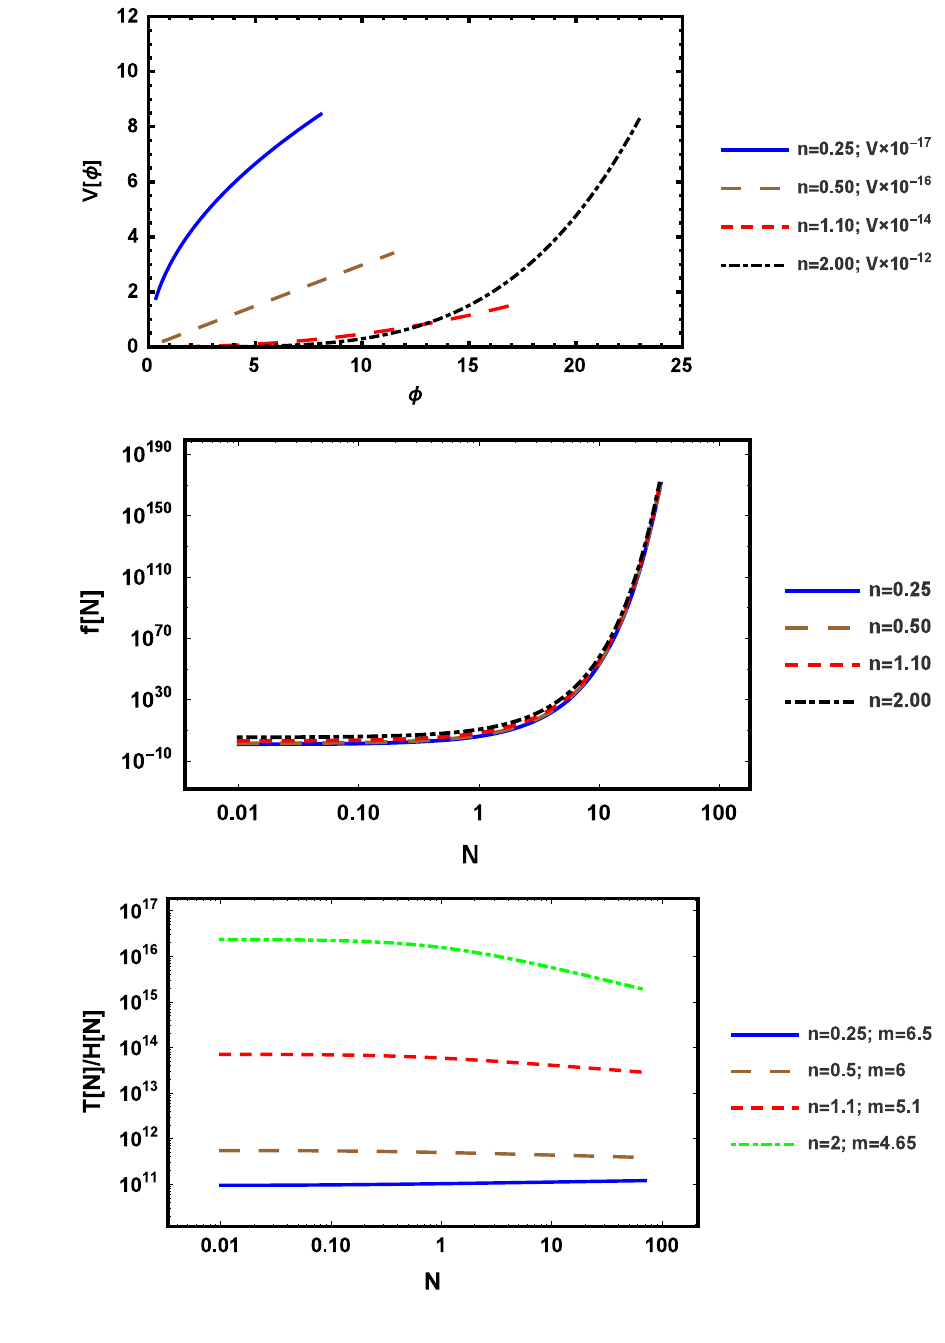
Fig. 3 The behavior of the coupling function f ( N ) versus the number of e-fold for different values of n (in a logarithmic scale). The function has an exponential behavior and when approaching to the end of inflation it rapidly decreases